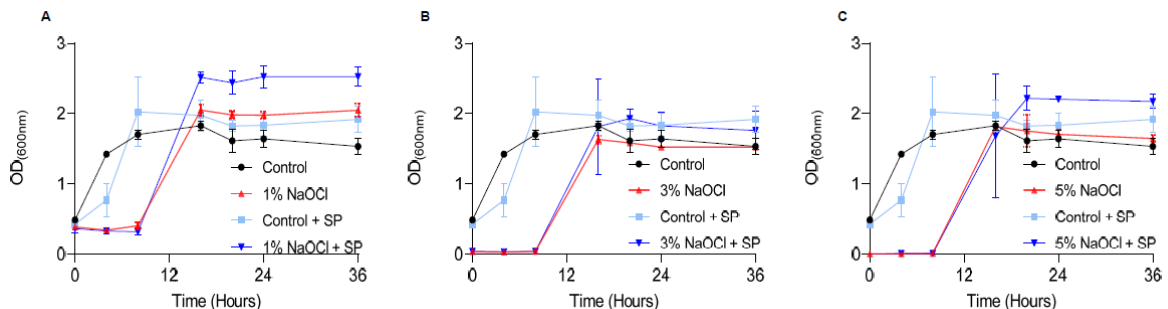
Figure 3. Sodium hypochlorite irrigation results in the regrowth of biofilm cells. E. faecalis cells were diluted 1:25 into a fresh TSB medium. 1000 µ L of cultures were split into a 12-well polystyrene plate and further incubated at 37 ◦ C for 24 h. Biofilm was untreated or treated with different concentrations of NaOCl (1% ( A ), 3% ( B ), or 5% ( C )) for 5 min. Bacterial cells were collected with 200 µ L PBS and added to 3mL of TSB medium applied with 0.5% glucose either applied or not with sodium pyruvate (2mg/mL) and regrown at 37 ℃ with shaking. OD600 was measured at different time points (0 h, 4 h, 8 h, 16 h, 20 h, 24 h and 36 h). Graphs represent the mean ± SD from three independent experiments ( n = 9). Statistical analysis was performed using two-way ANOVA followed by Dunnett’s multiple comparison test. p < 0.05 was considered statistically significant.